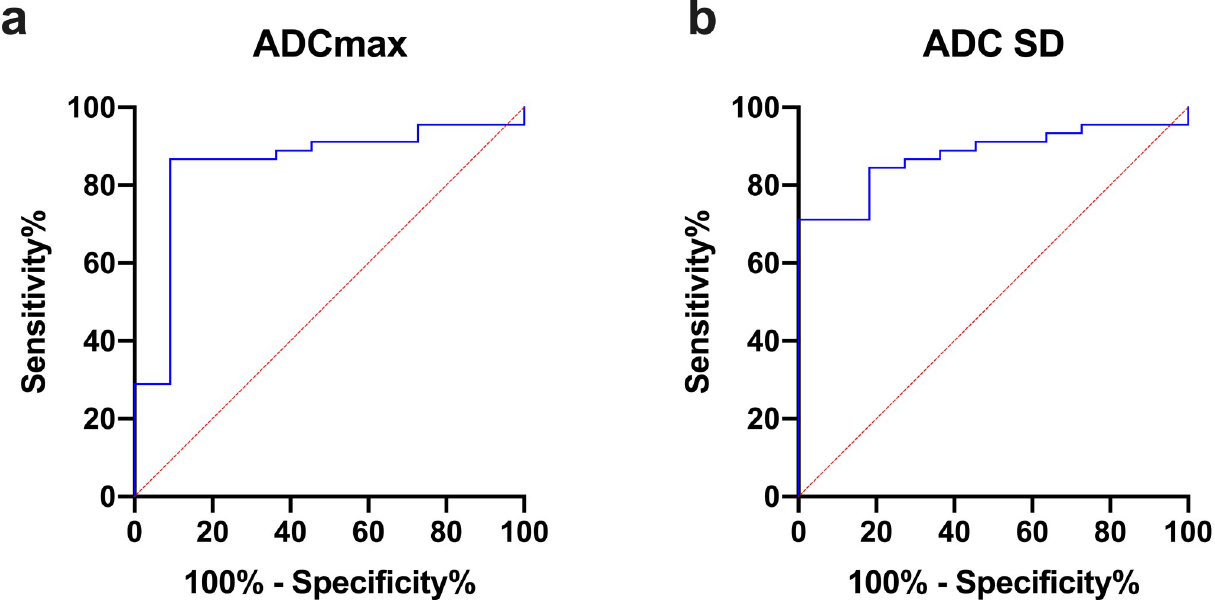
Fig 3. ROC curves. Fig 3 shows the receiver operating characteristics (ROC) curve of ADCmax (a) and ADC SD (b), the parameters with the highest AUC values and therefore the best accuracy in terms of discrimination between grade III and grade IV gliomas.